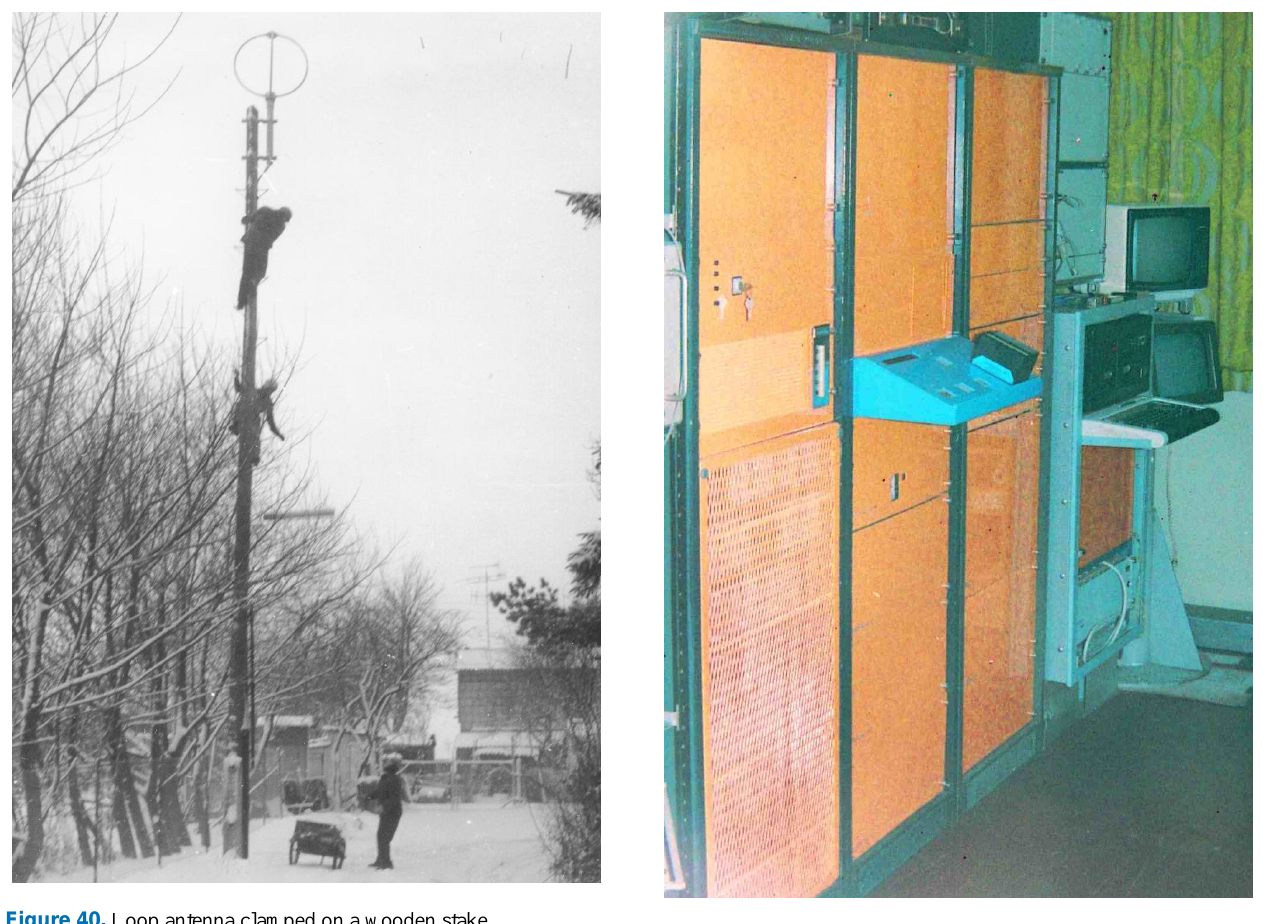
Figure 42. The new MF radar,